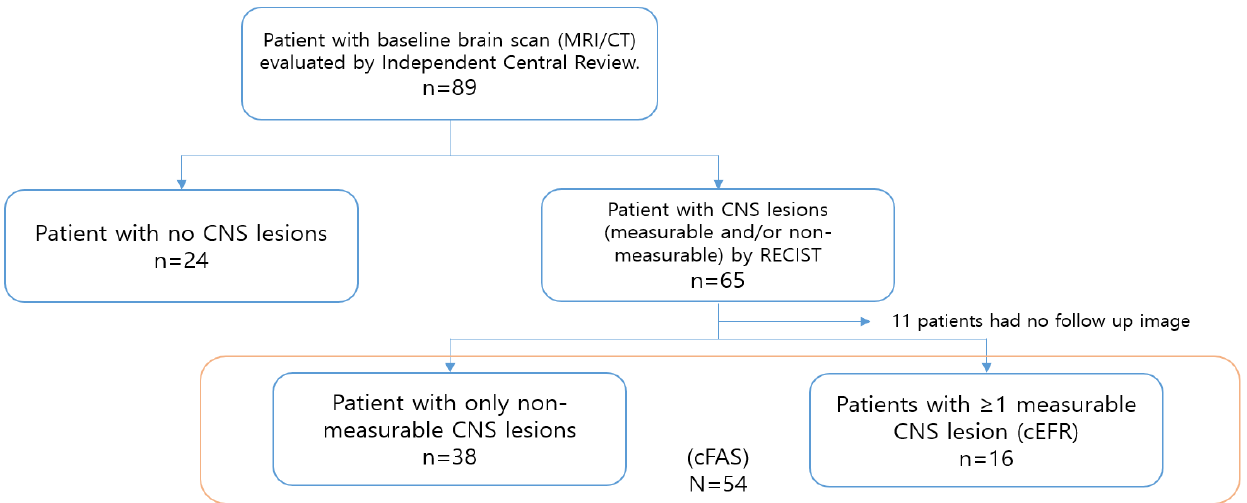
Figure 1. CONSORT diagram. cEFR, CNS evaluable for response set; cFAS, CNS full analysis set; CT, computed tomography; MRI, magnetic resonance imaging; RECIST, Response Evaluation Criteria in Solid Tumors.